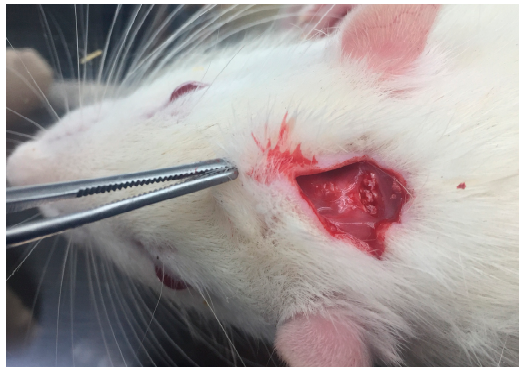
Figure 1. Surgical procedure of the subperiosteal bone graft. A horizontal step incision was made on the posterior portion of calvarial bone, and subperiosteal dissection was performed. A subperiosteal pocket was made on the parietal bone of calvarium, and the anorganic bovine bone (ABB) alone and the ABB with 5 and 50 µg of recombinant human bone morphogenetic protein-2 (rhBMP-2) were grafted in the pocket.